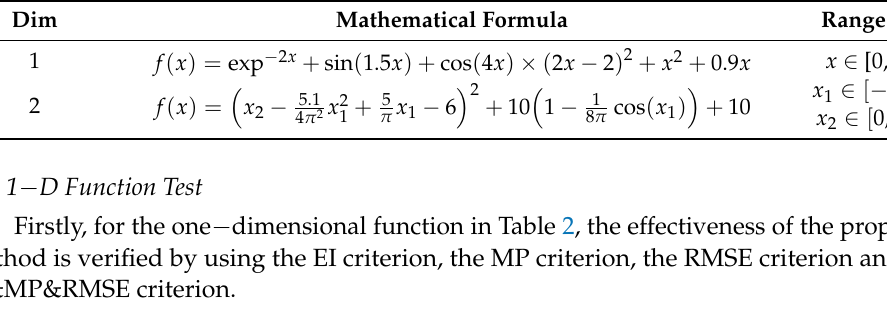
Table 2. 1 − D function related validation